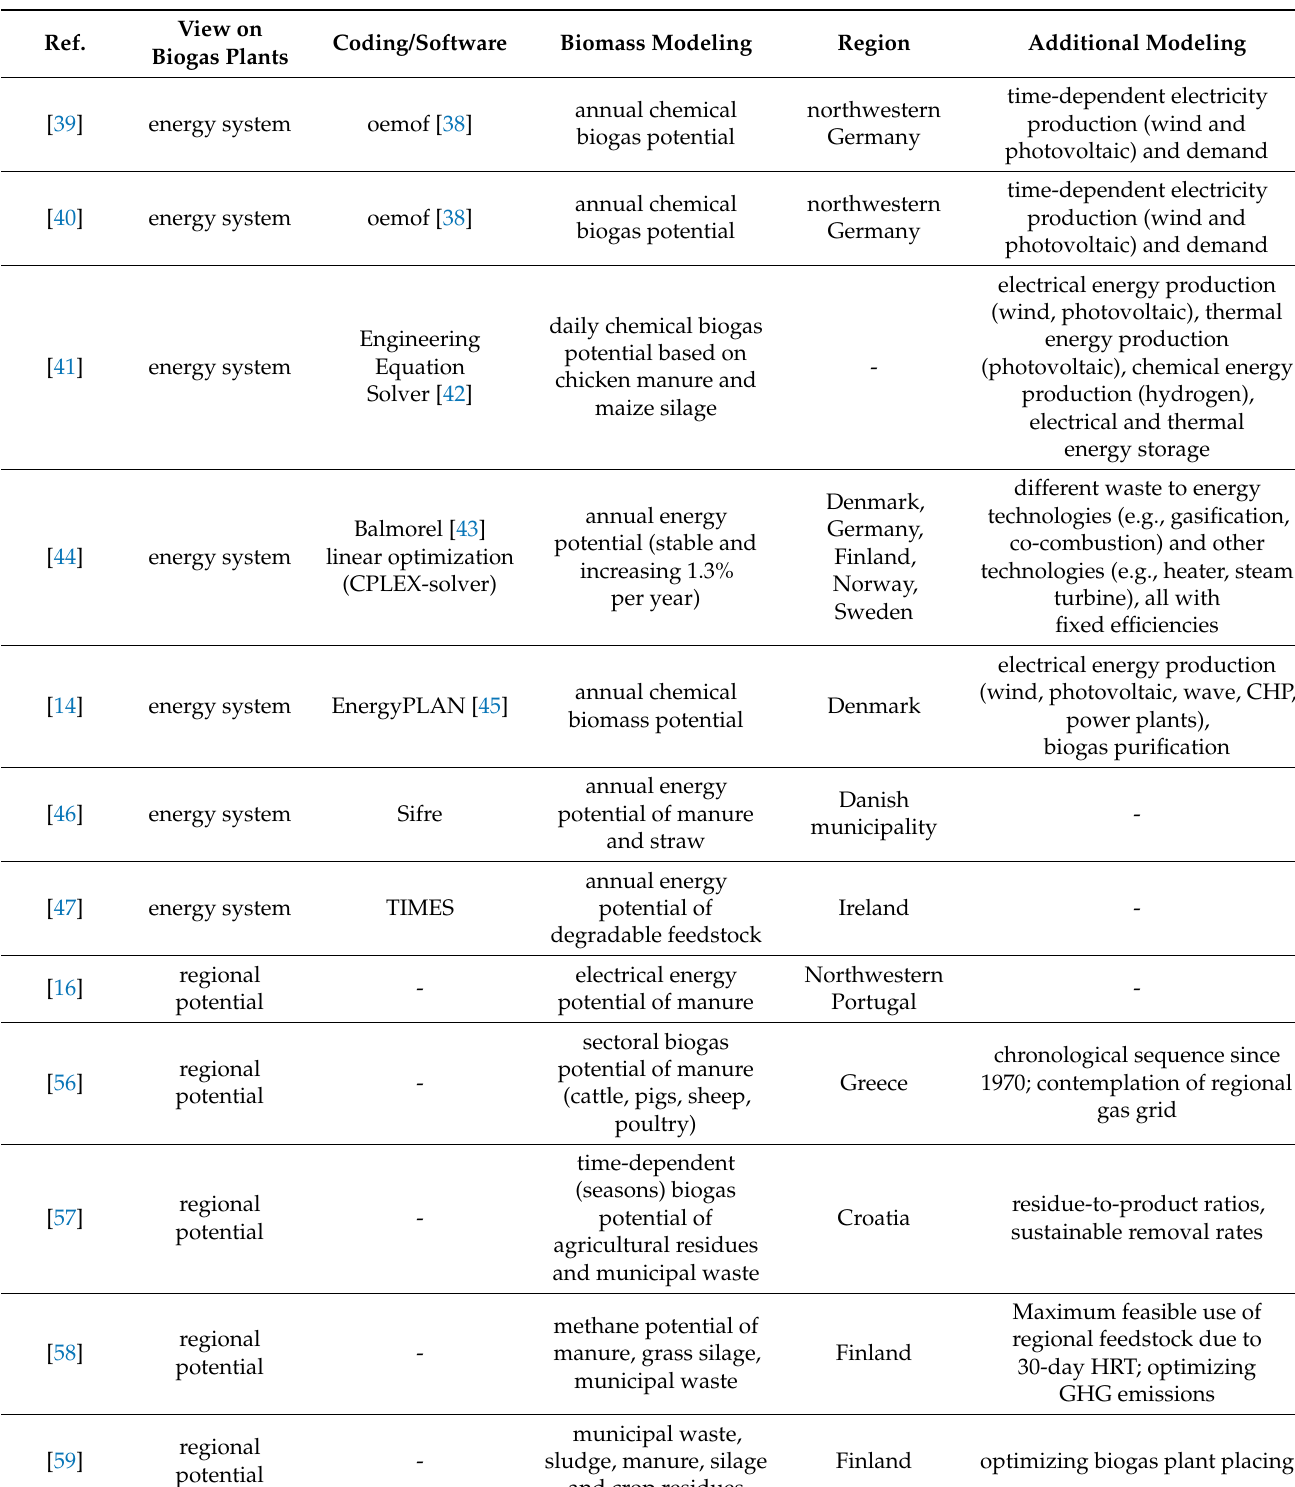
Table 1. Biogas top-down modeling (energy systems, regional impact, greenhouse gas (GHG) emission).